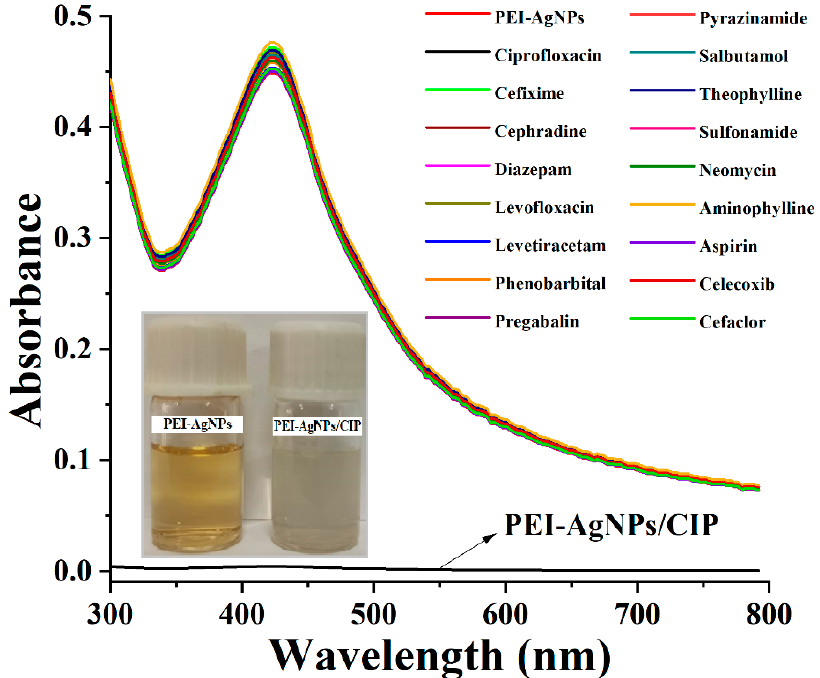
Figure 2. UV-visible spectra of PEI-AgNPs before and after individual addition of CIP and other pharmaceutical drugs; Drug concentration: 1.0 mM, PEI-AgNPs (1:15), optical path length 1 cm.